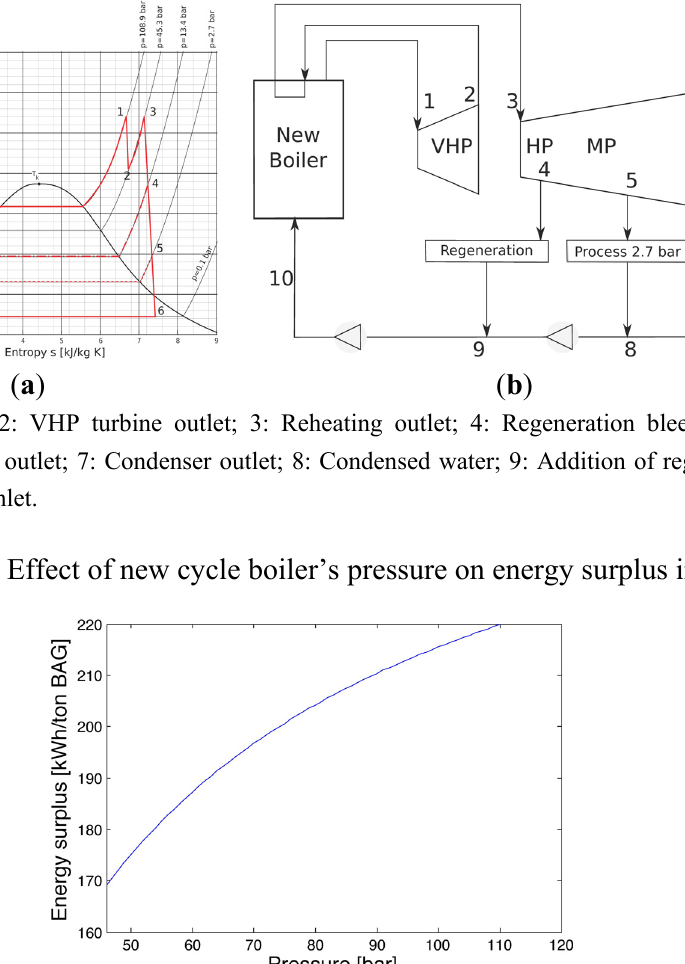
Figure 12. ( a ) T-s diagram of Option 2 Repowering; ( b ) Layout of Option 2 Repowering.